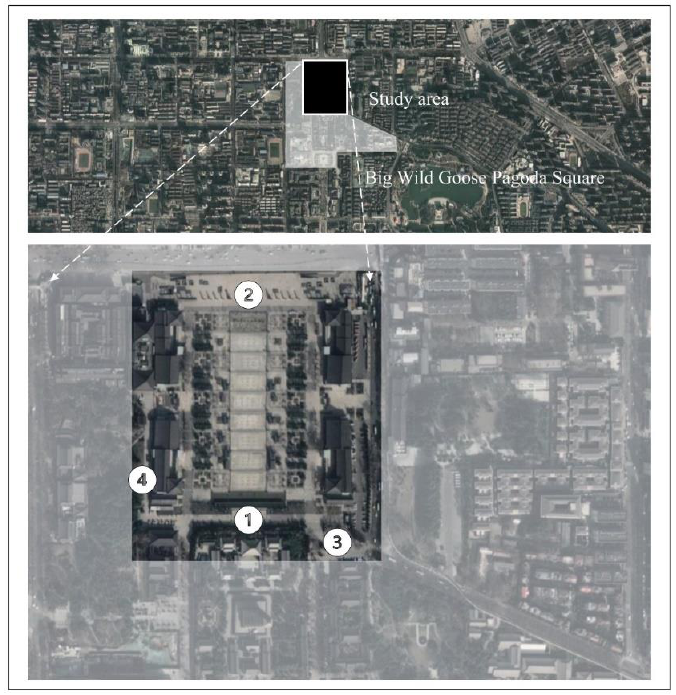
Figure 1. Study area location and Sites